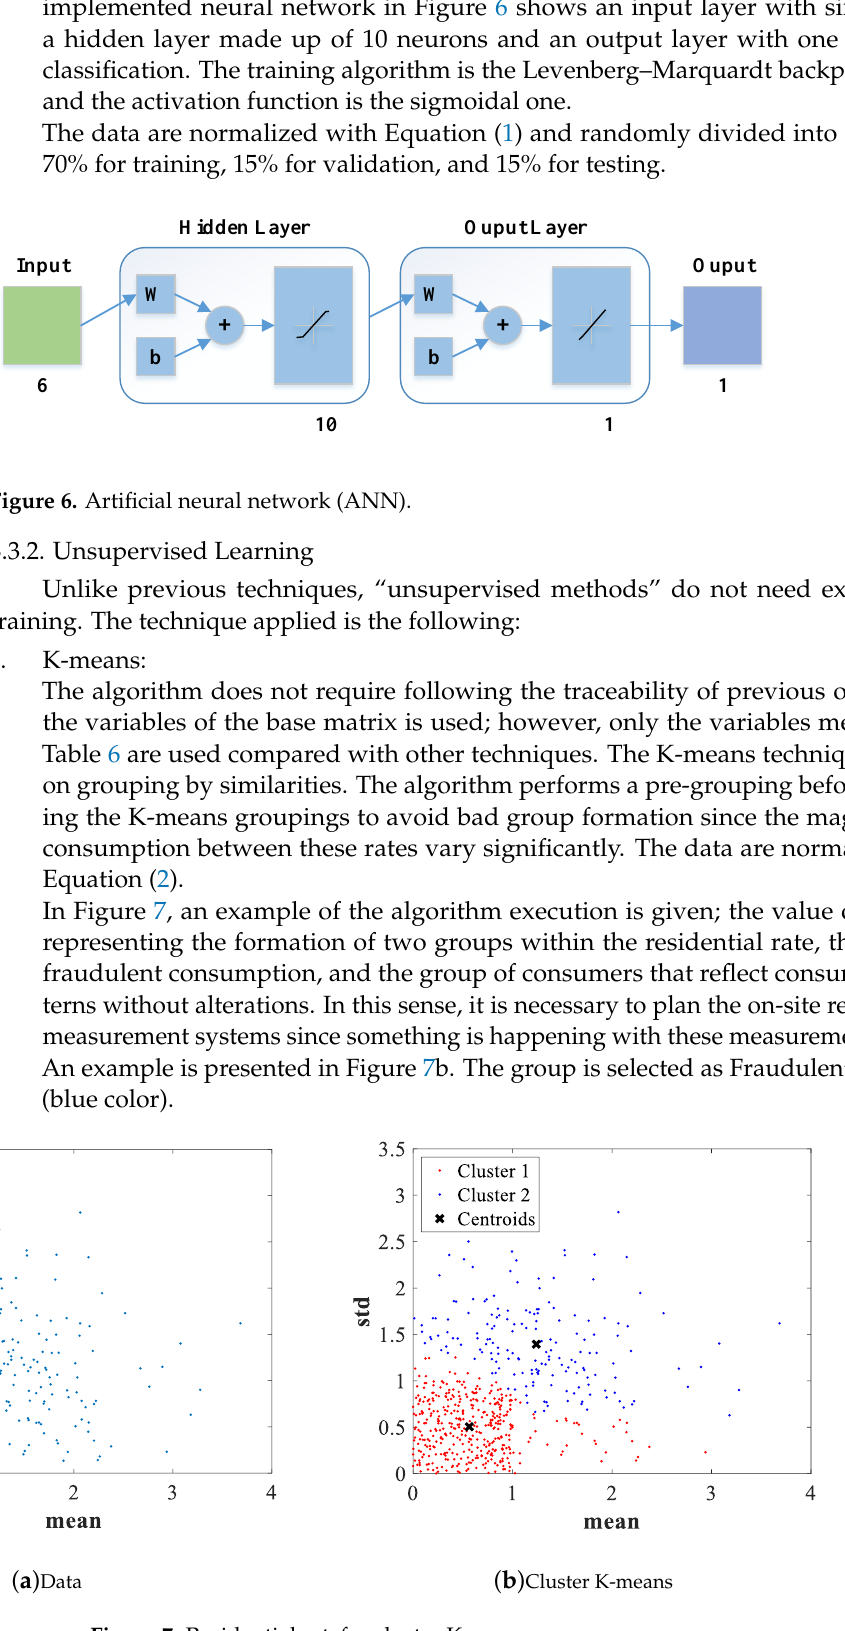
Figure 7. Residential ratefor cluster